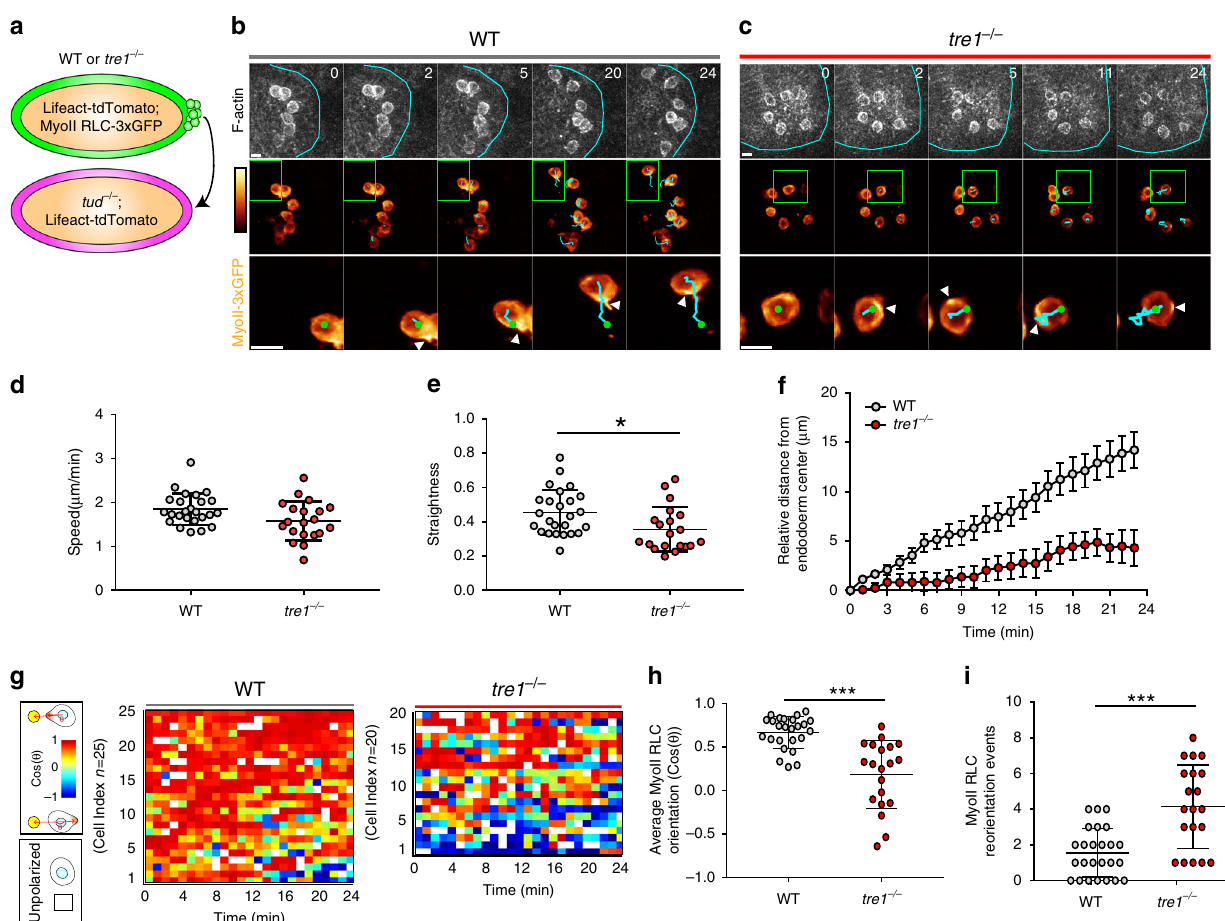
Fig. 4 Migration machinery is stabilized and oriented to drive PGC detachment. a Schematic describing transplantation of PGCs with the indicated genotypes into embryos genetically devoid of PGCs. Two photon timelapse imaging of representative transplanted WT ( b ) and tre1 − / − ( c ) PGCs. Cyan outlines the endoderm in the top set of panels. Myosin II RLC-3xGFP is pseudocolored with color bar indicated on the left (intensity ranges: 793 – 3616 ( b ), 801 – 3509 ( c )). Green box indicates expanded region on the bottom row of images. Green circles mark nuclei, cyan lines indicate cell tracks, and white arrows highlight regions of myosin II RLC-3xGFP accumulation. Representative images are from n = 10 embryos in ( b ) and n = 14 embryos in ( c ). Times are in minutes. Scale bars, 10 μ m. Quanti fi cation of speed ( d ), straightness ( e ), and relative distance from the endoderm center ( f ) for transplanted WT ( n = 25 PGCs from 10 embryos) and tre1 − / − ( n = 20 PGCs from 14 embryos) PGCs. Data are presented as mean values ± SD in ( d , e ). Error bars are SEM in ( f ). Statistical comparisons are from a Mann – Whitney test in ( e ) with p = 0.0149. * p = 0.05. g Quanti fi cation of myosin II RLC 3xGFP polarity angles in single WT or tre1 − / − PGCs. Each row shows the angles of a single cell over time. Polarity angles are pseudocolored as indicated on the left with the yellow circle representing the endoderm center, while a white box indicates when no polarity was detected. Quanti fi cation of average Myosin II RLC orientation ( h ) and Myosin II RLC reorientation events ( i ) (Shift > 60°) in WT ( n = 25 PGCs from 10 embryos) and tre1 − / − ( n = 20 PGCs from 14 embryos) PGCs. Data are presented as mean values + / − SD. Statistical comparisons are from a Mann – Whitney test with p < 0.0001 in h and p = 0.0002 in ( i ). *** p < 0.001. Source data in ( d – i ) are provided as a Source Data fi